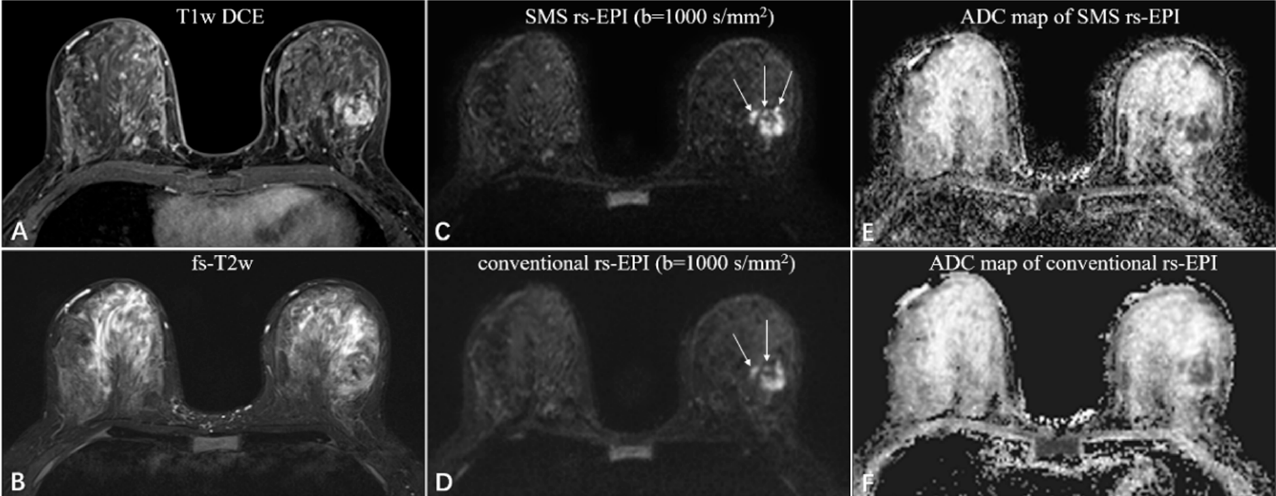
Figure 4. A 46-year-old woman with invasive ductal carcinoma in the left breast. The irregular mass with heterogeneous enhancement and multiple small foci around on the T1-weighted DCE images ( A ), and equal-to-low signal intensity on the fat-saturated T2-weighted images ( B ). The SMS rs-EPI image ( C ) shows better sharpness of anatomical details (pointed by long white arrows) and less anatomic distortion than rs-EPI image ( D ). The ADC signal is obviously decreased in both sequences ( E , F ).